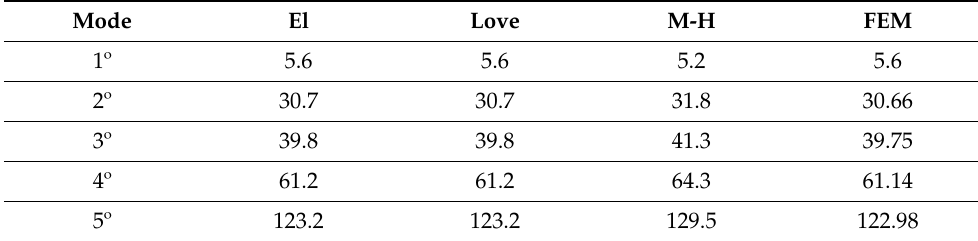
Table 2. First five tower‘s resonance frequencies for four